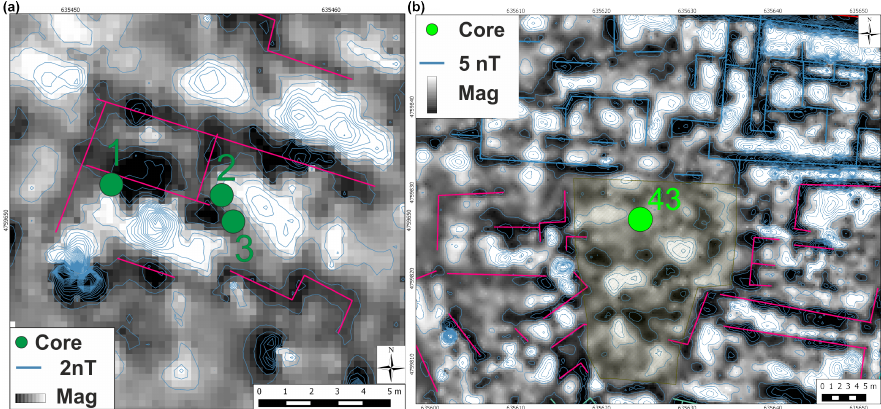
Figure 5. ( a ) Location of the BH1, BH2 and BH3 over the magnetic survey results, where some linear anomalies attributed to a building are identified. The area is highlighted in the general context of Figure 6. ( b ) Location of the BH43 over the magnetic survey results, where an area without remarkable magnetic anomalies and surrounded by buildings have been attributed to a possible open area. The area is highlighted in the general context of Figure